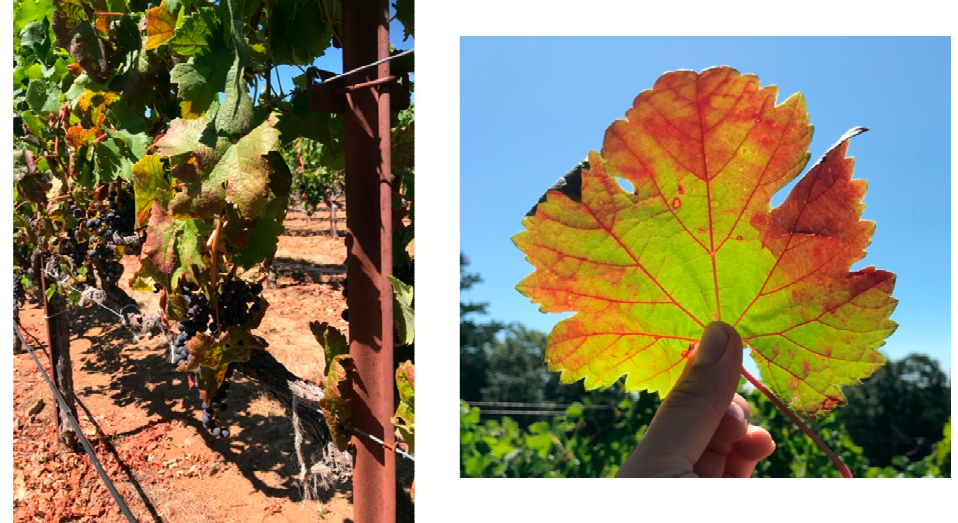
Figure 2. Foliar symptoms of GRBD in Merlot grapevines in Napa, CA, USA. Photo credit: Arran Rumbaugh.